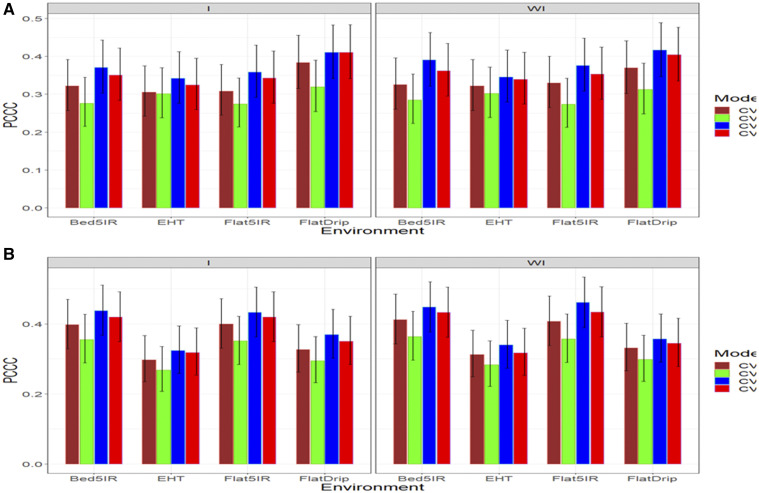
Prediction performance of the proposed MAPT model in terms of the proportion of cases correctly classified (PCCC) for traits: A) DTHD and B) DTMT of data set 4, under four values of coefficient of variation (CV). The smaller the CV, the more informative the prior. The left panel is with interaction (I) and the right panel is without interaction (WI).